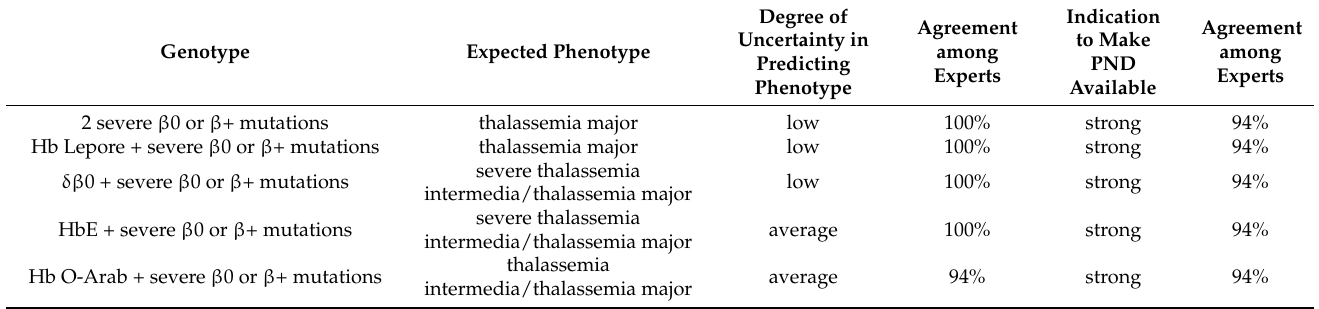
Table 12. Prenatal diagnosis orientation